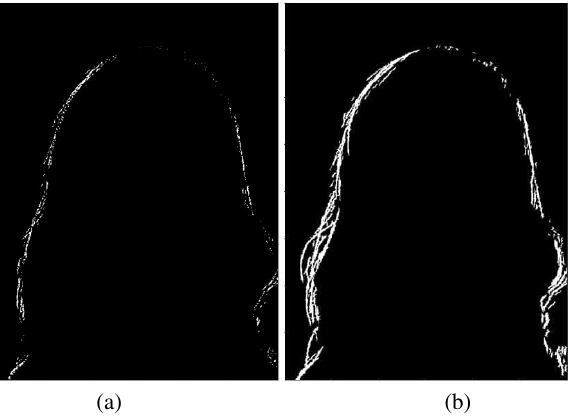
Figure 6. Building the curves: (a) the starting points of